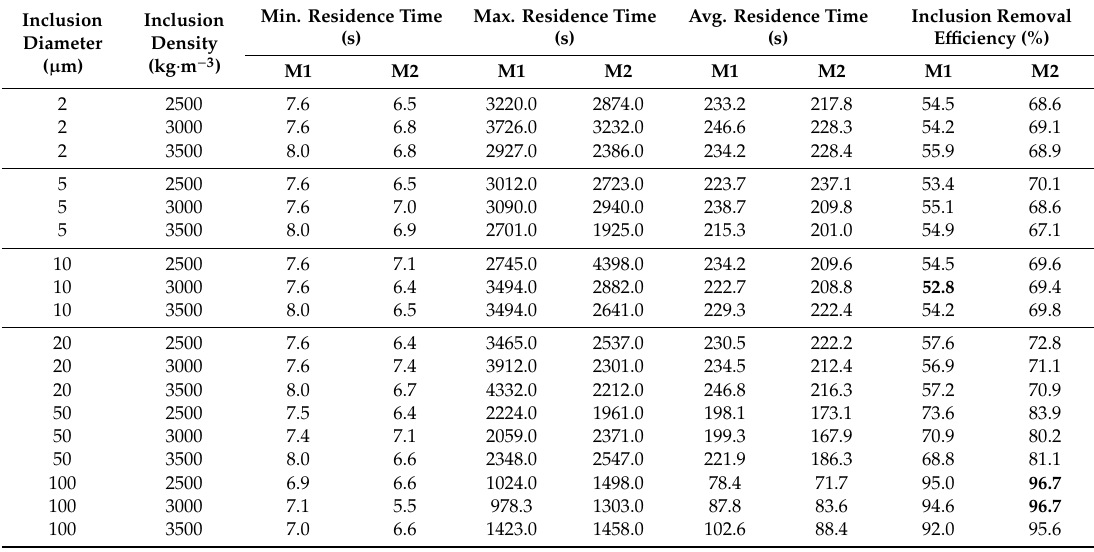
Table 8. Comparison of residence times of inclusions and e ffi ciency of their removal through the melt surface for individual fractions represented in the steel casting strand through a shroud tube by a 100%